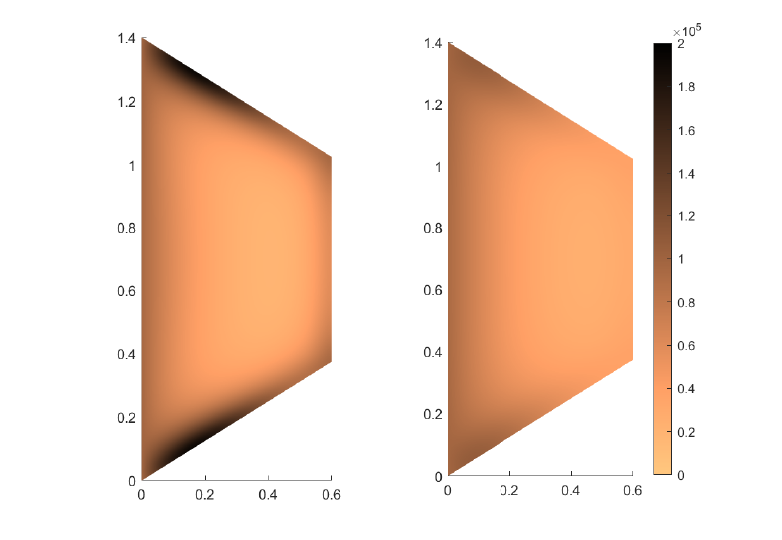
Figure 10. Concentration of osteoblasts at the final time for the case of p m = 0.5 (left) and p m = 0.1